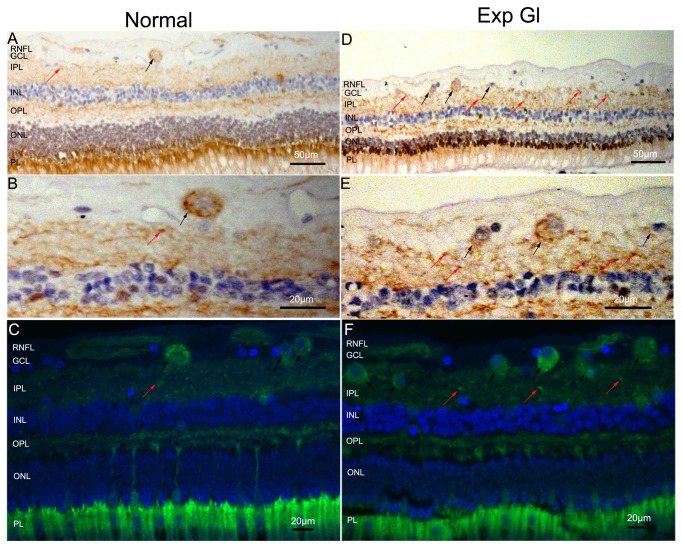
Immunolocalization analysis of LC3B in the normal and exp gl retinas.The nucleus (blue) was immunolabeled with hematoxylin for immunoperoxidase labeling (A, B, D and E) and with DAPI for immunofluorescent analysis (C and F). LC3B immunoreactivity was observed as clusters of small, intensely stained granules, which were brown in A, B, D and E and green in C and F. A, C, D and F. Strong increases in LC3B expression were observed in the GCL (black arrows) and IPL (red arrows) in the glaucomatous retinas compared with the normal retinas. B, C, E and F. With higher magnification, a markedly increased number of positive granules are visible in the cytosol of the RGC in the GCL (black arrows) and in the dendrites of the RGC in the IPL (red arrows) in the glaucomatous retinas compared with the normal retinas. (A, D scale bar=50 μm; B, C, E and F scale bar=20 μm). .